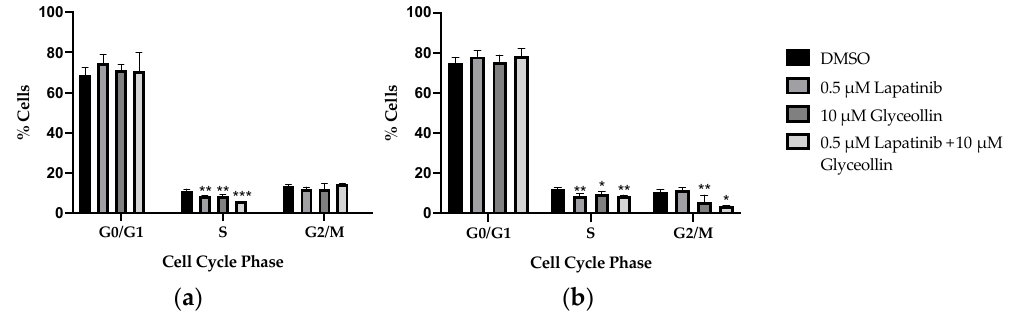
Figure 5. Glyceollin alone and in combination with lapatinib inhibit G1/S and G2/M cell cycle progression in T47DaromLR breast cancer cells. ( a ) The T47Darom and ( b ) the T47DaromLR cells were assessed by flow cytometry for cell cycle progression after treatment with the vehicle control (DMSO), 0.5 μ M lapatinib, 10 μ M glyceollin, and 0.5 μ M lapatinib + 10 μ M glyceollin for 24 h. Cells were detached, washed, fixed, and stained with PI. Cell cycle analysis was determined as described in the methodology. Student’s t -tests were performed, and treatments were compared to the DMSO control. Results are expressed as a percentage of total cells ± SD (*** p < 0.001, ** p < 0.01, * p < 0.05) of three independent experiments in triplicate. Table 1. Glyceollin and lapatinib alter cell cycle distribution. This table illustrates the number of cells analyzed and percent distribution of cells entering the various stages of the cell cycle. Numbers in parentheses indicate the total number of cells in each phase.